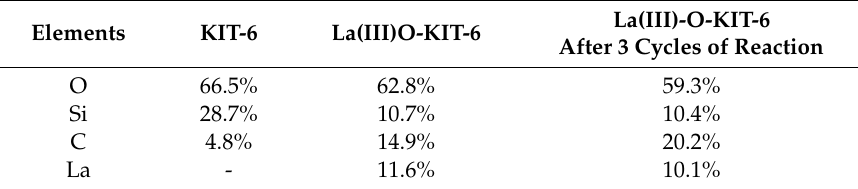
Table 1. Elemental composition of (a) support KIT-6, (b) catalyst ( 2) , and (c) catalyst ( 2) after the 3rd recycle.